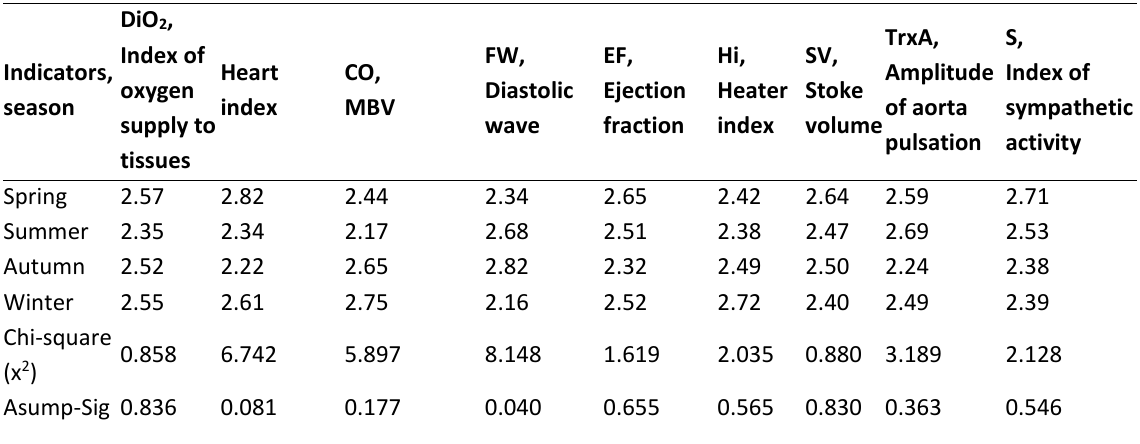
Table 2. Season fluctuations of students’ cardio-respiratory indicators by Freedman’s criterion (group of comparison, n=40)